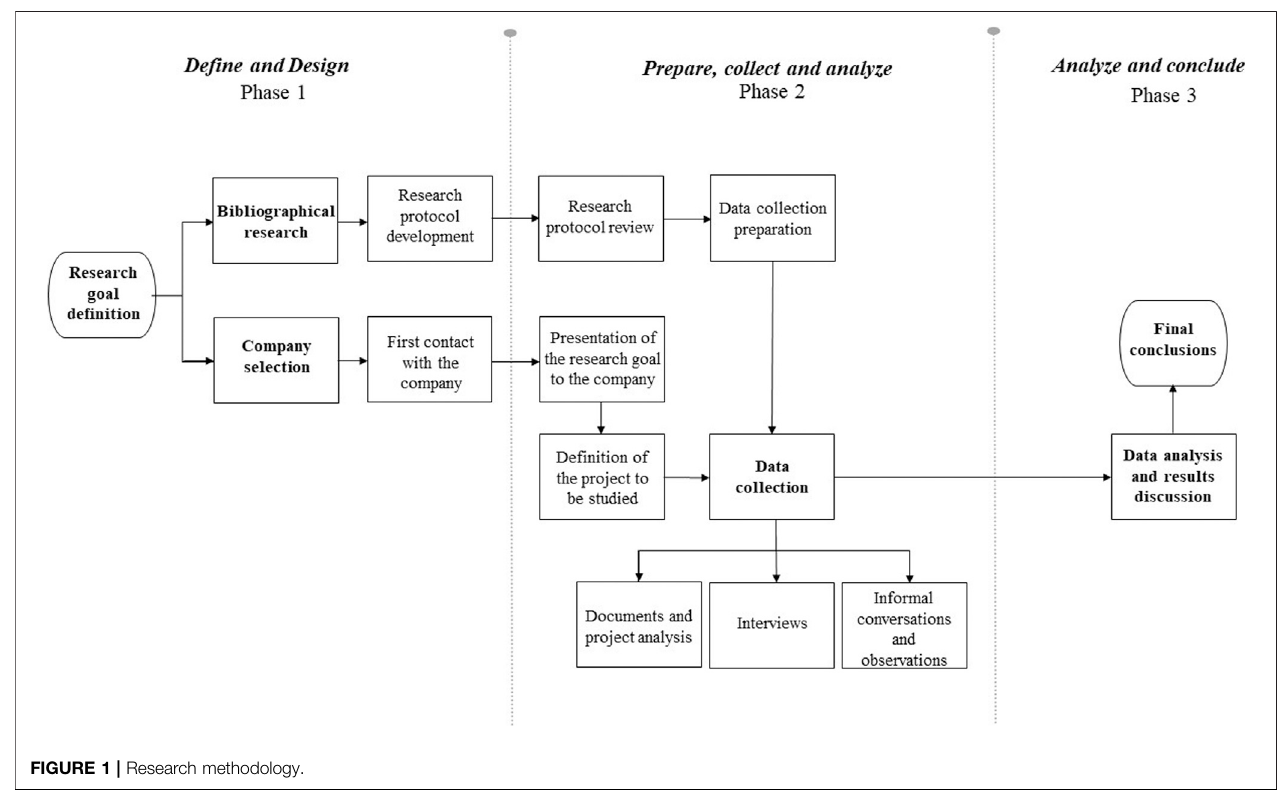
FIGURE 1 | Research methodology.